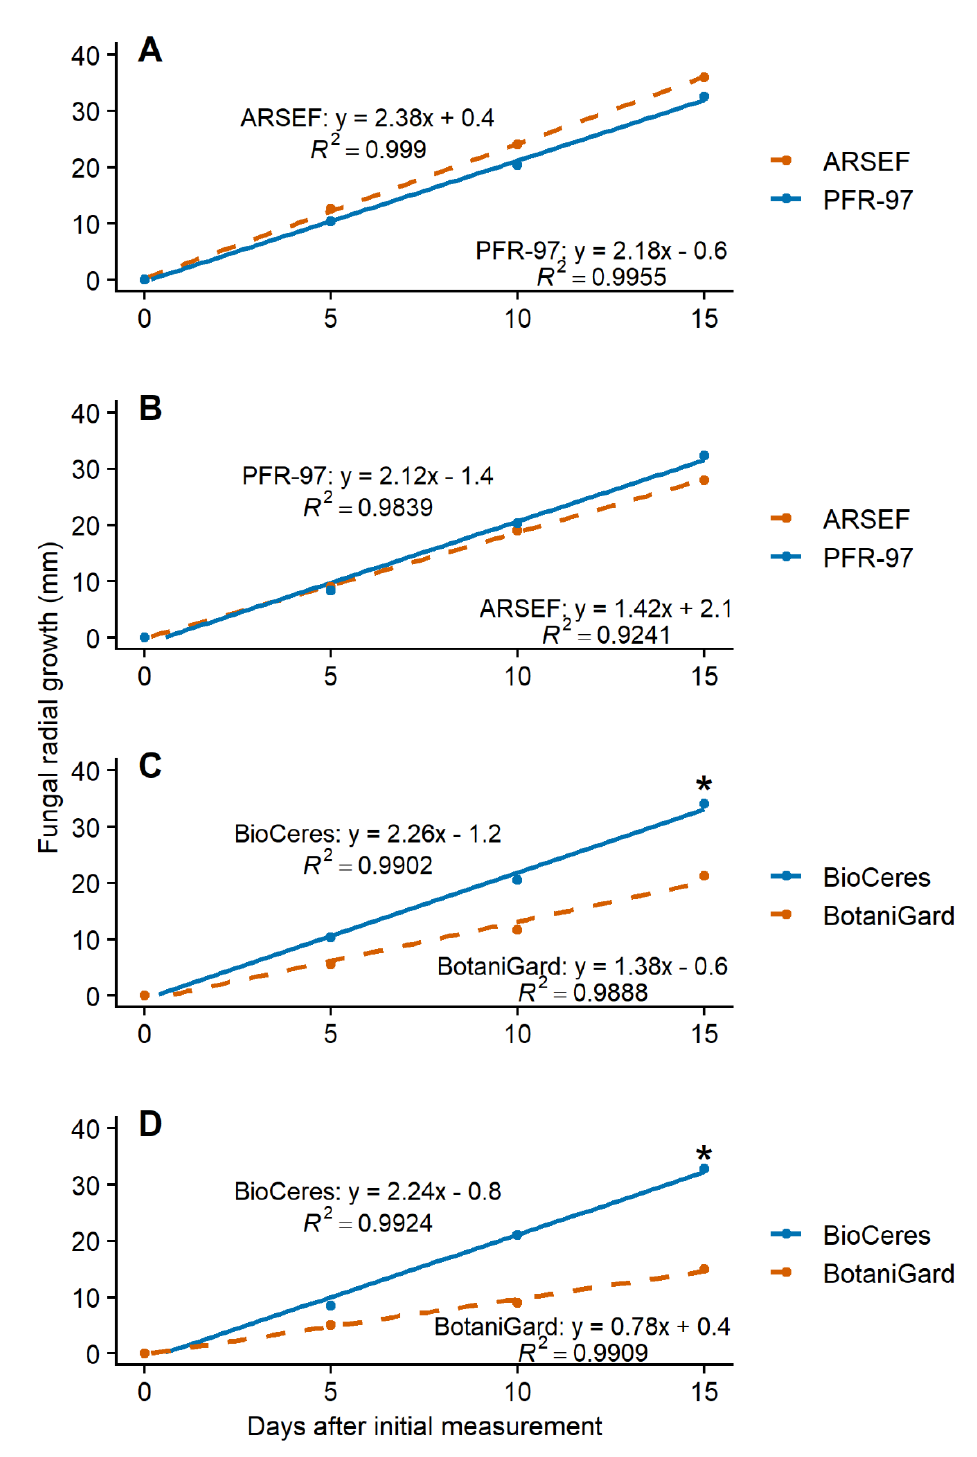
Figure 5. Linear models of fungal radial growth over 15 days that compare fungal products of the same species grown on PDA with bok choy ( A , C ) or turnip ( B , D ) leaf extract. Models for PFR-97 and BioCeres are based on 50% leaf extract concentration; models for ARSEF and BotaniGard are based on 25% because radial growth was fastest at this concentration. Asterisk (*) above a line endpoint represents significance between treatment models (Student’s t -test, p < 0.05).